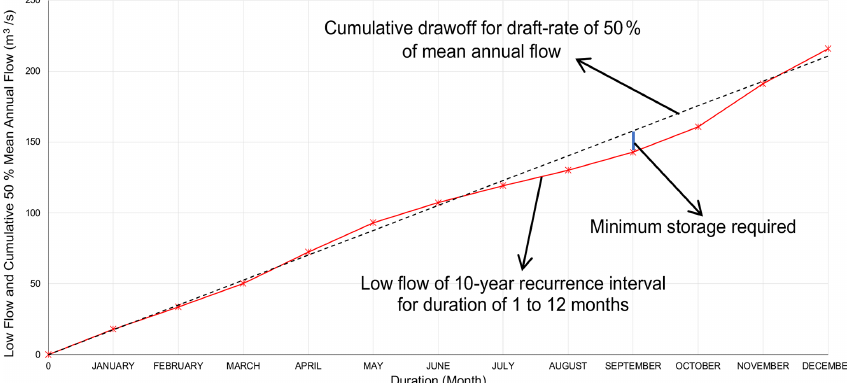
Figure 3. Minimum storage required using mass curve